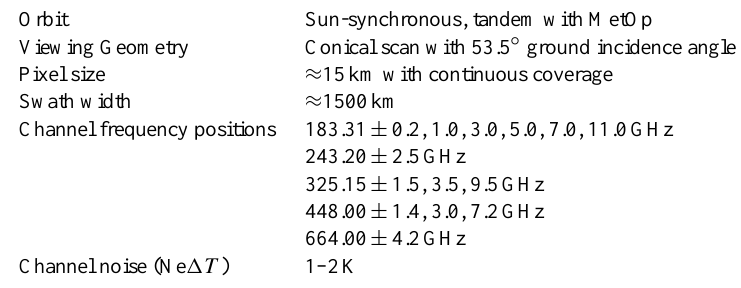
Table 1. An overview of some core parameters of CloudIce. For more detailed information see Tables 3 and 4.